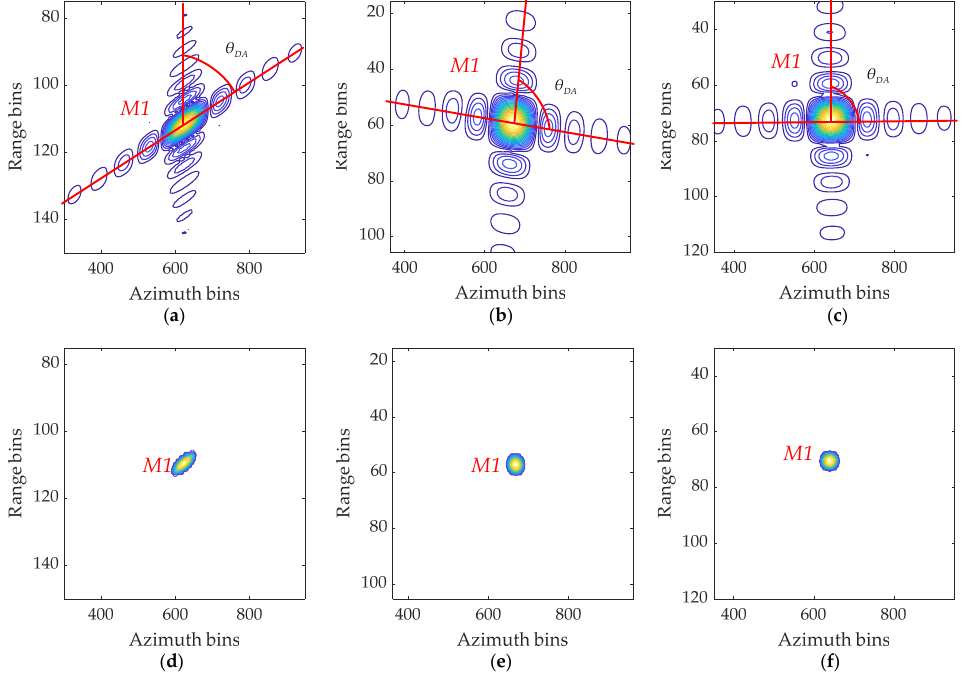
Figure 10. Moving target focused image and sparse enhancement image with or without spectrum rotation: ( a ) Focused image without spectrum rotation; ( b ) Focused image with SASR; ( c ) Focused image with ESASR; ( d – f ) Sparse enhancement image of ( a – c ), respectively. Table 1. Comparison of imaging quality indexes.